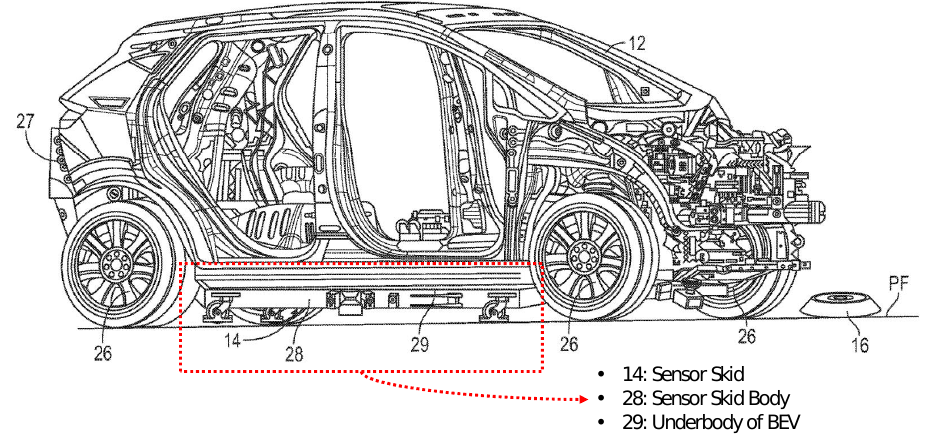
Figure 3. Sensor skid based VaaC implementation. Figure 3. Sensor-skid-based VaaC